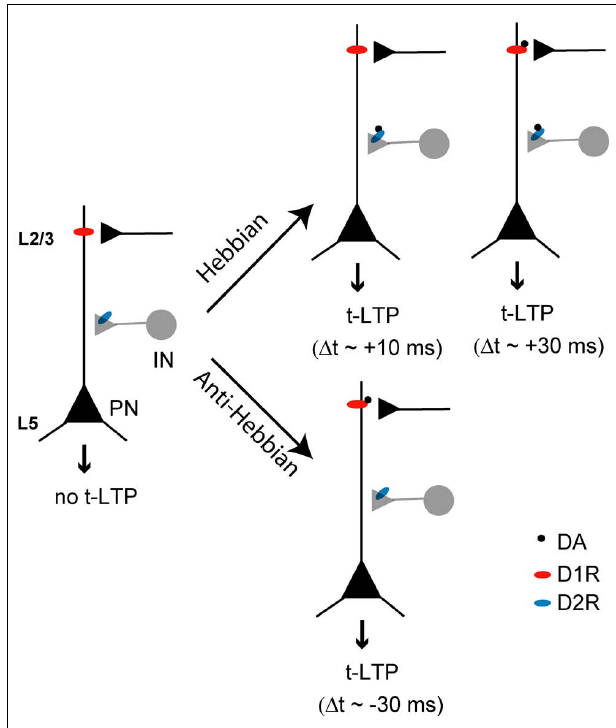
FIGURE 7 |A model for DA enabling of t-LTP in native PFC circuits. t-LTP is absent when tissue DA level is minimal.When its concentration rises, DA can gate Hebbian t-LTP across a timing window of 0 → + 30 ms. However, the mechanisms of t-LTP induction at different timings vary: at Δ t = + 10 ms, DA gates t-LTP induction through suppression of presynaptic GABA release by activating D2Rs at GABAergic terminals. At Δ t = + 30 ms, DA gates t-LTP induction through both suppression of presynaptic GABA release via D2Rs and postsynaptic activation of cAMP/PKA signaling downstream to D1Rs, highlighting the need of concurrent activation of both D1Rs and D2Rs in separate excitatory and inhibitory circuits. In contrast, negative-timing t-LTP can be gated by DA as well, but this form of anti-Hebbian t-LTP can be induced by activating postsynaptic D1Rs alone without the need to suppress GABAergic transmission involving presynaptic D2Rs in inhibitory circuits. Consequently, circuit cooperativity is not necessary for DA-enabled anti-Hebbian t-LTP. PN, pyramidal neurons; IN, interneurons; L2/3, layer 2/3; L5, layer